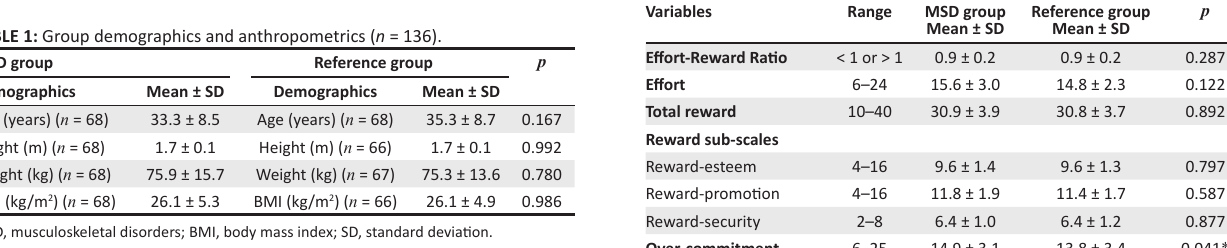
TABLE 3: Effort-reward imbalance and over-commitment in the musculoskeletal disorders group ( n = 68) and the reference group ( n = 68).